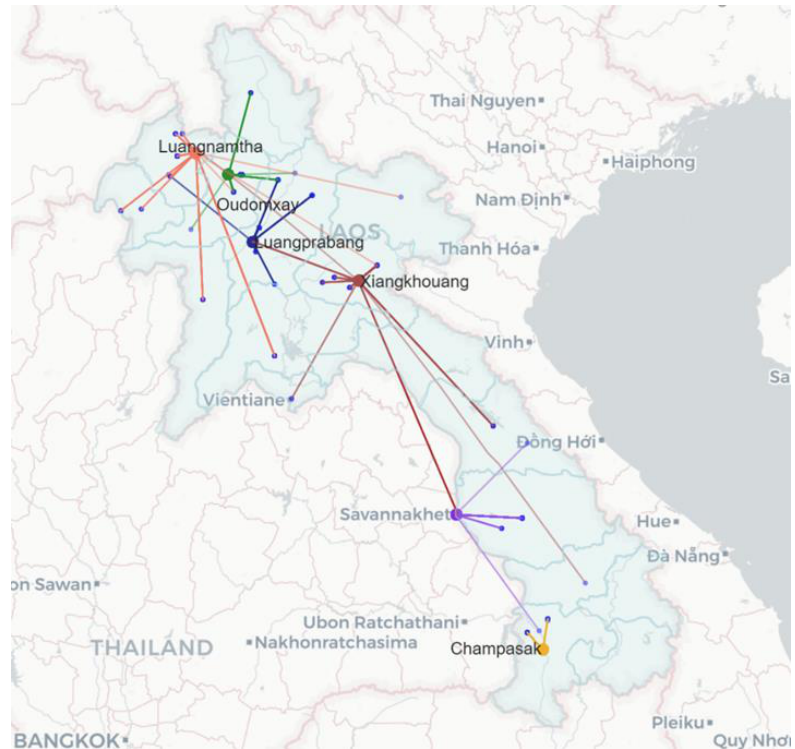
Figure 3. Animal movement map from a source of origin (blue dot) to an abattoir in the six provinces (LNT = orange, ODX = green, LPB = Navy, XK = brown, SVK = violet and CPS =